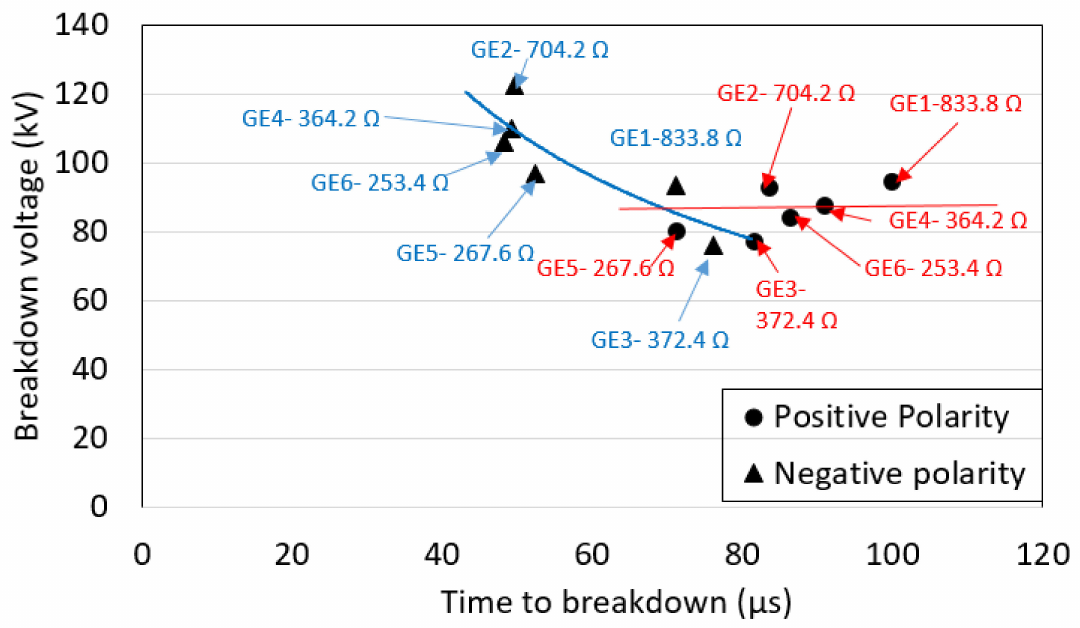
Figure 11. Breakdown voltages vs. time to breakdown for all GEs, with their corresponding R DC